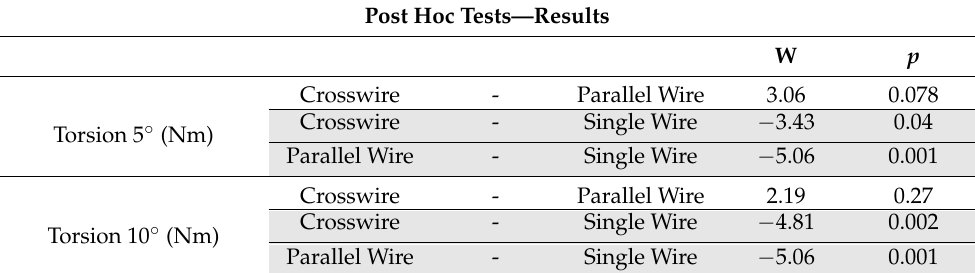
Table A6. Results of the post hoc (Dwass–Steel–Critchlow–Fligner pairwise comparisons) tests for the different fixation methods (Group I, II, and III) during the 5 ◦ and 10 ◦ torsion tests. The level of significance was set to 5% ( α = 0.05). Statistically significant ( p < 0.05) results are highlighted with light